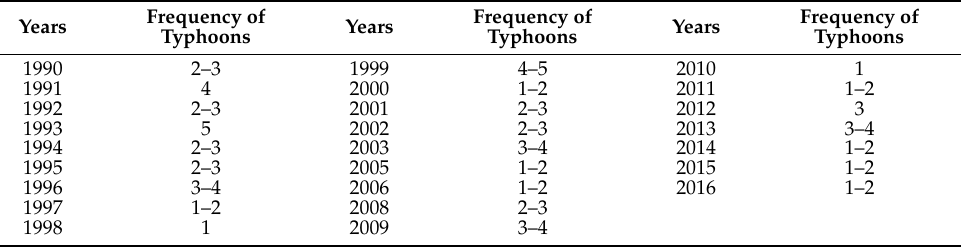
Table 3. The most likely frequency of